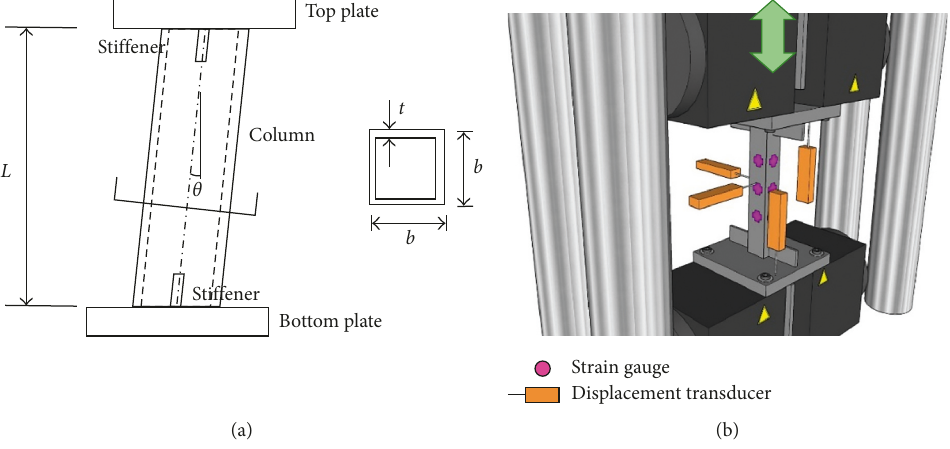
Figure 2: CFST column sample and instrumental setup.